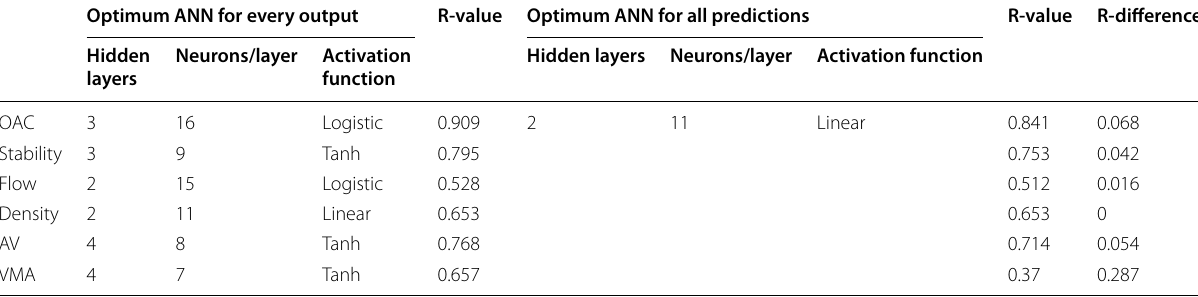
Table 10 Comparison between the optimum ANN for every output and the optimum ANN for all predictions Optimum ANN for every output